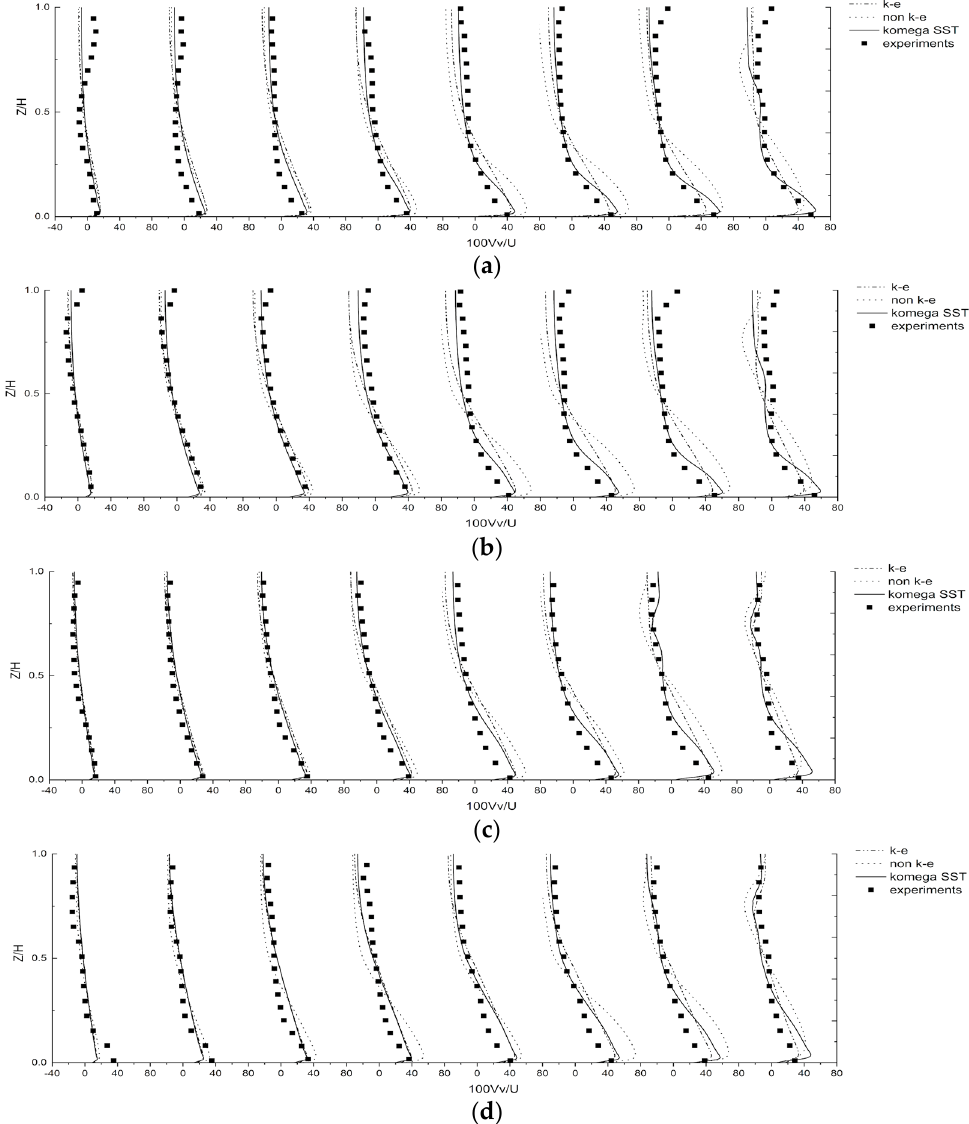
Figure 4. Distribution of transverse component of velocity at 90 degrees with different jet conditions: